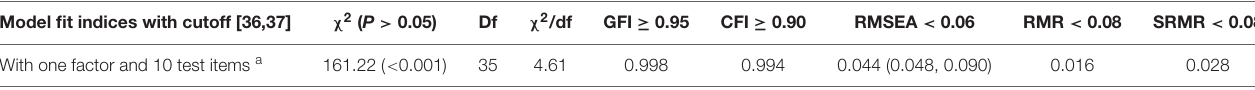
TABLE 3 | Fit statistics for the one-factor model of the Chinese version of the Family Communication Scale in the community-based sample ( N = 1,983). Model fit indices with cutoff [36,37] χ 2 ( P > 0.05) Df χ 2 /df GFI ≥ 0.95